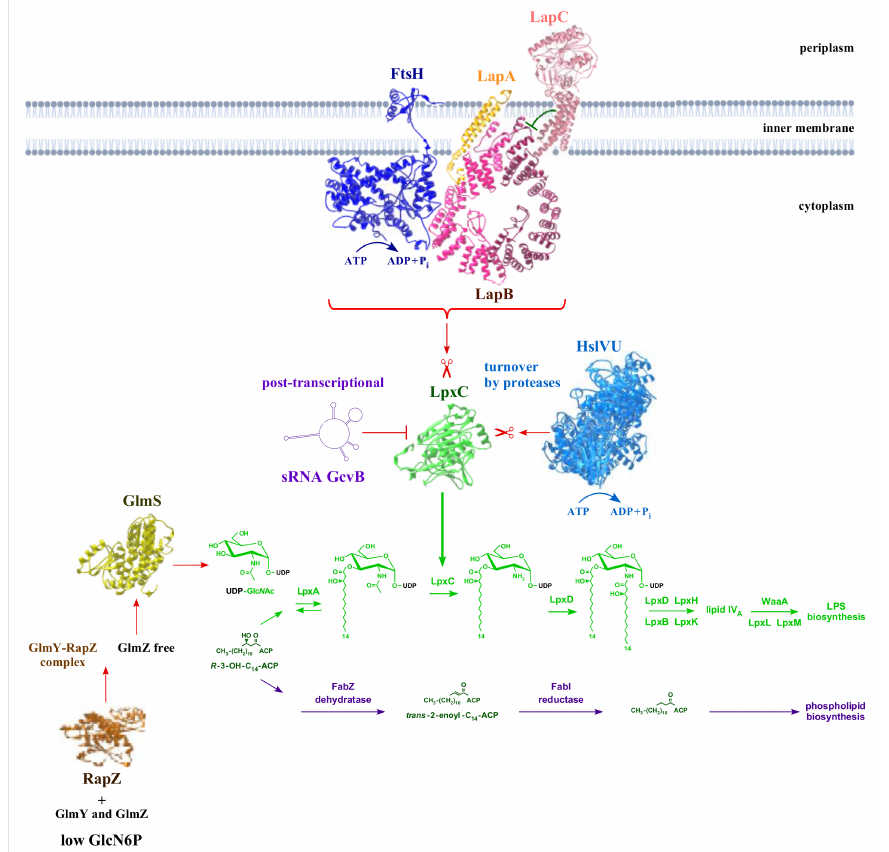
Figure 1. Regulation of the first committed step in LPS biosynthesis catalyzed by LpxC. On the top schematic drawing of the interaction between LapB and LapC in the inner membrane, and scissors depict LpxC proteolysis by FtsH and HslVU proteases. The LpxC synthesis is also subjected to negative post-transcriptional regulation by the GcvB sRNA. At the bottom, the recruitment of UDP-GlcNAc and ( R )-3-hydroxymyristate precursors in LPS biosynthesis is shown. The same ( R )-3- hydroxymyristate precursor is used by FabZ in phospholipid biosynthesis. UDP-GlcNAc synthesis requires GlmS, whose amounts are regulated by GlmY and GlmZ sRNAs, requiring RapZ as an adaptor